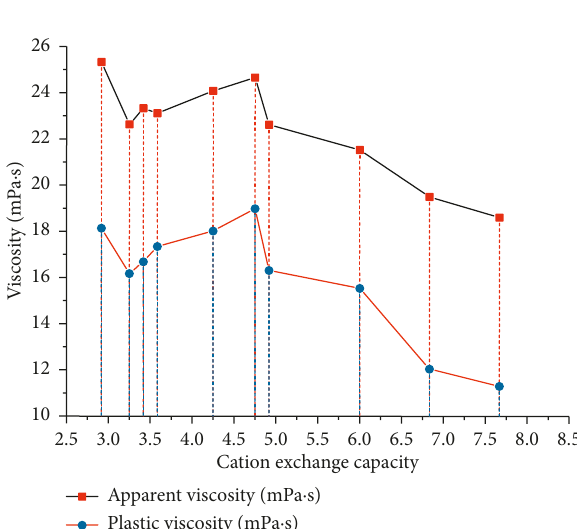
Figure 8: Curve of viscosities of the slurry fluid.